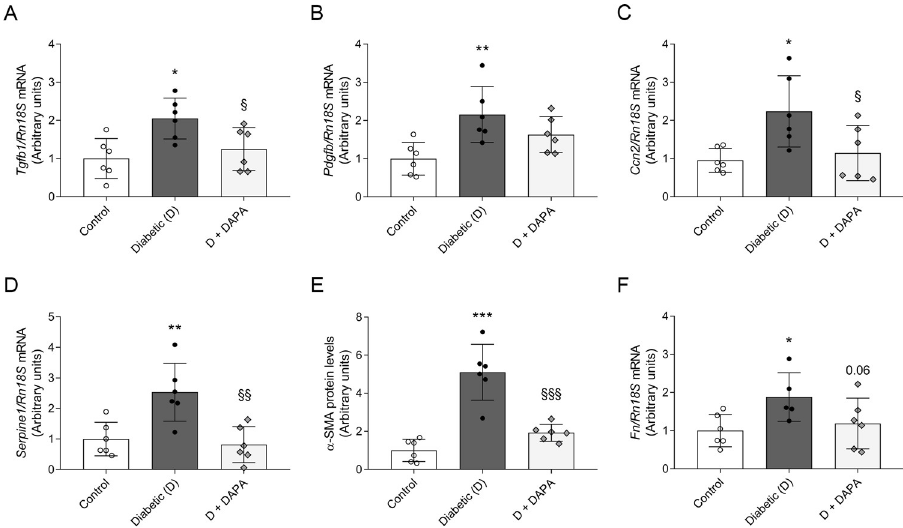
Fig 4. Dapagliflozin attenuates fibrosis in the left ventriculum of diabetic rats. mRNA expression of (A) transforming growth factor β ( Tgfb1 ), (B) platelet-derived growth factor ( Pdgfb ), and (C) connective tissue growth factor ( Ccn2 ) of control, diabetic and dapagliflozin treated diabetic rats (D+DAPA). (D) mRNA expression of Serpine1 (also known as plasminogen activator inhibitor-1). (E) Protein level of α -smooth muscle actin ( α -SMA). Proteins were normalized to total protein Ponceau S staining as loading control. (F) mRNA expression of fibronectin (Fn) . mRNA expressions were normalized to Rn18S mRNA expression. Bars indicate means ± SDs and data were analyzed by one- way ANOVA with Holm-Sidak multiple comparisons test (n = 6/group) � p < 0.05 vs . Control, �� p < 0.01 vs . Control, ��� p < 0.001 vs . Control, § p < 0.05 vs . Diabetic, §§ p < 0.01 vs . Diabetic, §§§ p < 0.001 vs . Diabetic.